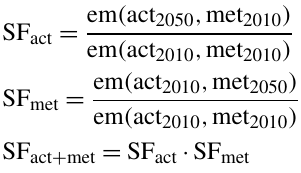
(Eq. 1) and meteorology (met) (Eq. 2). Future 2054